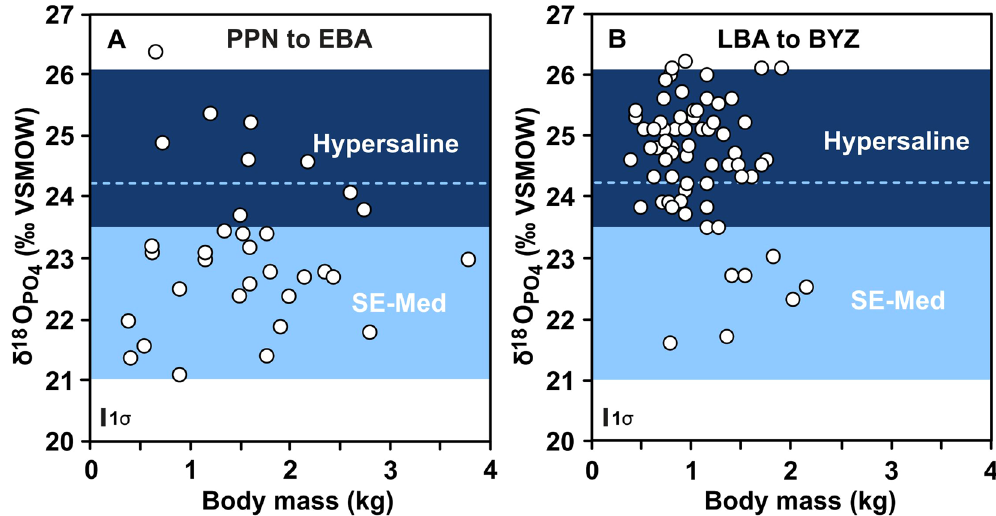
Figure 5. Enameloid phosphate oxygen isotope composition ( δ 18 O PO4 ) of S . aurata teeth versus estimated fish body mass (inferred from molariform tooth size; see text for details) for two different time intervals: ( A ) Pre- Pottery Neolithic (PPN) to Early Bronze Age (EBA): 9,700 to 3,000 BCE. The stippled light blue line marks the lower threshold for unambiguous hypersaline δ 18 O PO4 values of S . aurata from the Bardawil lagoon. Note